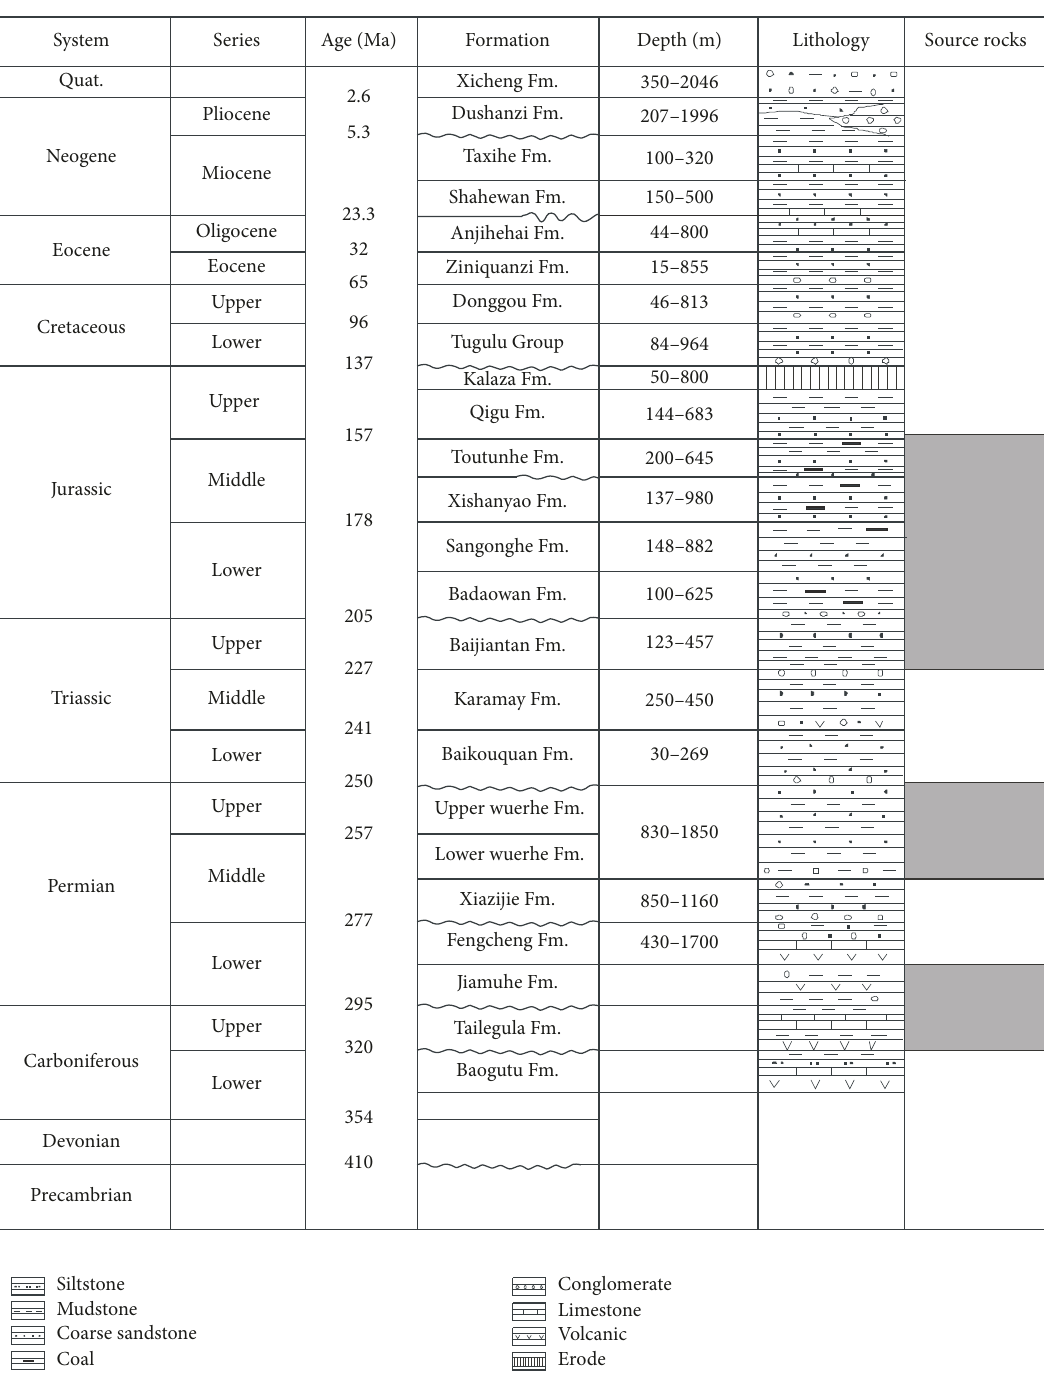
(Figure 7). 29 samples from Xishanyao Formation (J2x) and 11 samples from Toutunhe formation (J2t) were collected between 5500 m and 6200 m for the carbon and oxygen stable isotopic analysis. The results were shown in Figure 7